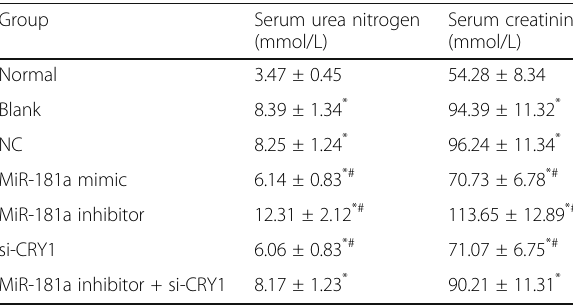
Table 3 Upregulation of miR-181a or downregulation of CRY1 decreases the contents of serum urea nitrogen and serum creatinine of CKD rats ( n =